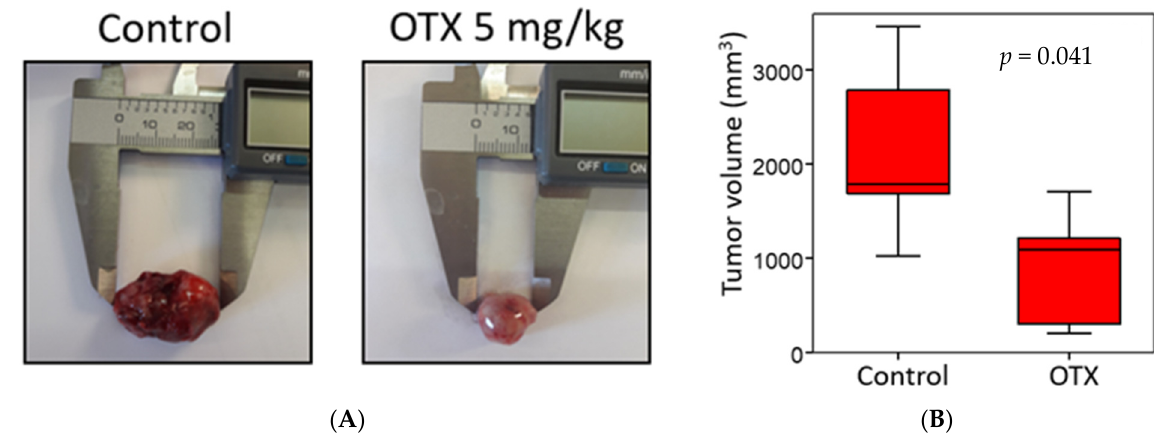
Figure 9. Effect of OTX008 on tumor volume developed from anaplastic cells in nude mice. ( A ) Illustration of two tumors and ( B ) box plot presenting tumor volume after mouse euthanasia in both control and OTX-treated groups. The Mann Whitney test was performed to assess significance.